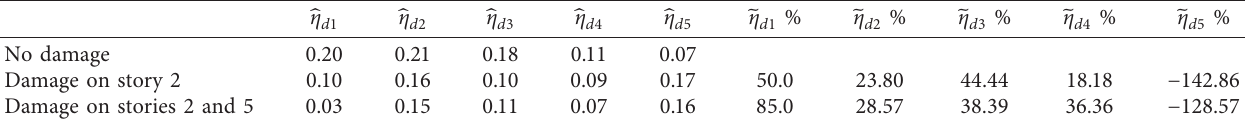
Table 4: Variation of the estimated parameters η